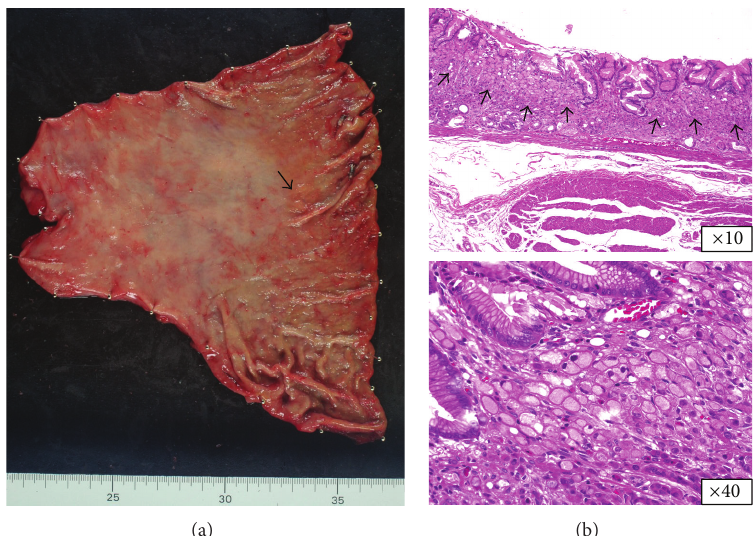
Figure 3: The surgically resected specimen and histopathological findings. Resected specimen from laparoscopy-assisted distal gastrectomy ((a) arrow: SRGC lesion). The tumor cells showed signet ring cell components (low magnification view × 10); high magnification (high magnification view × 40) of signet ring cell components ((b) arrows: signet ring cells limited to the mucosa).